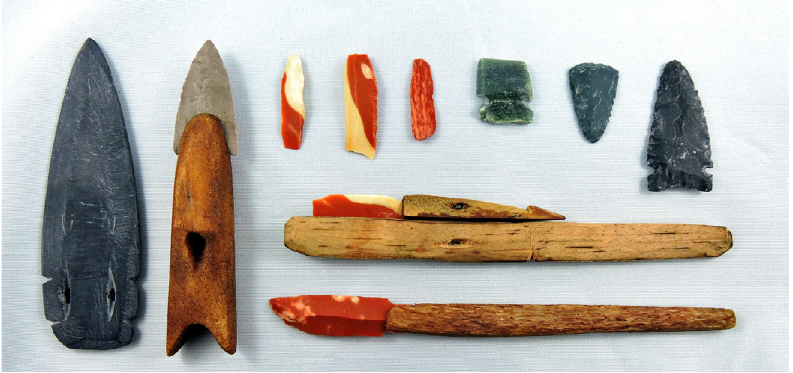
Figure 6: A selection of artifacts created by Tim Rast for the Dorset cultural layer of the excavation kit. Photo by Tim Rast.